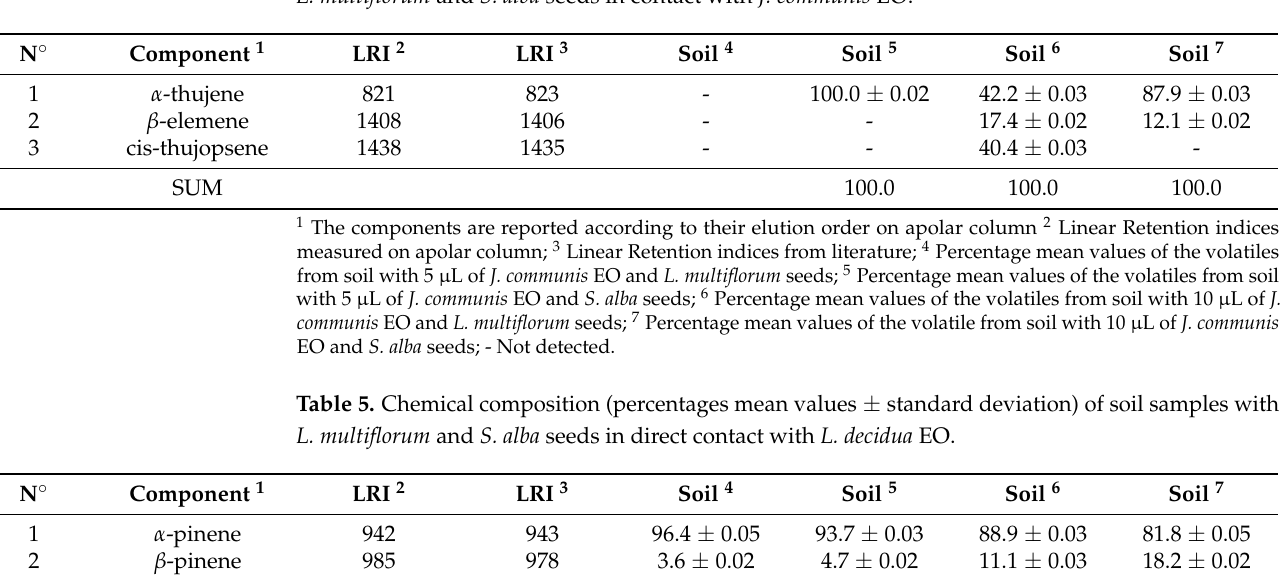
Table 4. Chemical composition (percentages mean values ± standard deviation) of soil samples with L. multiflorum and S. alba seeds in contact with J. communis EO.